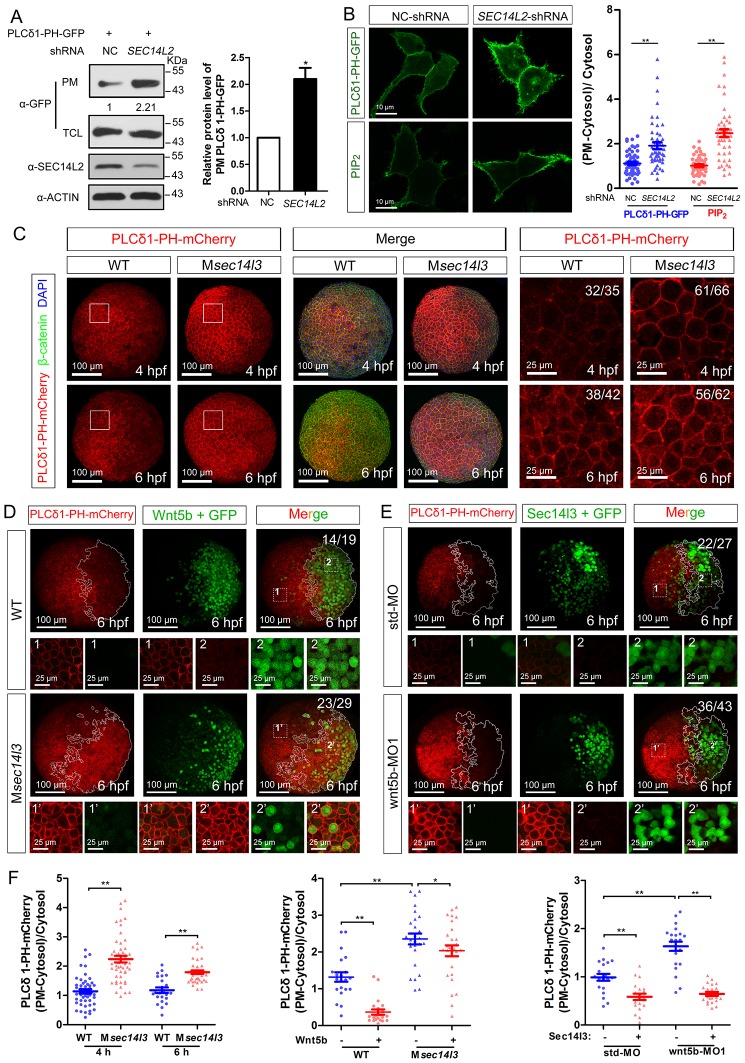
Sec14l3 facilitates PLC-catalyzed PIP2 hydrolysis induced by Wnt5b.(A) PM isolation analysis of PM PIP2 levels using PLCδ1-PH-GFP as probe in HEK293T cells. Quantification data from three independent experiments are shown as mean ± SEM (see also Figure 3—source data 1, *p<0.05). (B) Immunofluorescence of PLCδ1-PH-GFP in first panel (transfected with PLCδ1-PH-GFP) and endogenous PIP2 in second panel shows PIP2 accumulation in the PM of stable SEC14L2-knockdown HEK293T cells. Data are presented as mean ± SEM (see also Figure 3—source data 1, **p<0.01; n ≥ 50 cells from three separate experiments). Scale bar, 10 μm. (C) Immunofluorescence of PLCδ1-PH-mCherry (red, PIP2 probe), β-catenin (green, PM marker) and DAPI (blue, nucleus marker) shows PIP2 accumulation in the PM of Msec14l3 mutant cells. The first two whole embryo panels are 3D views of z-stacks (n = 30 for 4 hpf, n = 34 for 6 hpf), while the last panel is enlarged views of single z-stack pictures (z = 8 for 4 hpf, z = 7 for 6 hpf) from regions encompassed by white boxes. Scale bars, 100 μm for whole embryos; 25 μm for the enlarged columns. (D) Sec14l3 depletion compromises Wnt5b-induced degradation of PM PIP2. Immunofluorescence of PLCδ1-PH-mCherry (red) and GFP (green, indicating Wnt5b-expressed cells) is shown. Mosaic expression of 100 pg wnt5b mRNA was created in embryos with even distribution of PLCδ1-PH-mCherry mRNA. White polygons outline GFP expressed cells and single z-stack pictures (z = 10) from numbered regions in the whole embryo panels (3D view of z-stacks) are enlarged. Scale bars, 100 μm for whole embryos; 25 μm for the enlarged panels. (E) sec14l3 overexpression inhibits accumulation of PIP2 in wnt5b morphant embryos. Mosaic expression of sec14l3 by injecting 150 pg mRNA was created in embryos with even distribution of PLCδ1-PH-mCherry mRNA in std-MO or wnt5b-MO injected embryos. Single z-stack pictures (z = 11) from numbered regions in the whole embryo panels (3D view of z-stacks) are enlarged. (F) PM PIP2 quantification of (C–E) by calculating intensity of (PM-Cytosol)/Cytosol PLCδ1-PH-mCherry. Data are shown as mean ± SEM. (see also Figure 3—source data 1, **p<0.01; *p<0.05; ns, non-significant; n ≥ 50 cells from 10 embryos in three independent experiments).DOI:
http://dx.doi.org/10.7554/eLife.26362.01110.7554/eLife.26362.012Figure 3—source data 1.Numerical data for Figure 3A,B,F and Figure 3—figure supplements 1C–E and 2E.